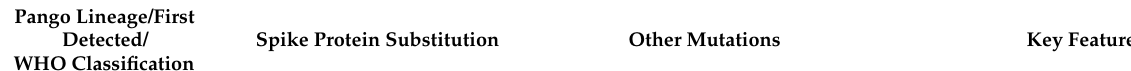
Table 3. Variants of Concern: Mutations and their key features. Table 2. Predominant Spike Mutations associated with SARS-CoV-2 variants. Table 2. Predominant Spike Mutations associated with SARS-CoV-2 variants. Table 2. Predominant Spike Mutations associated with SARS-CoV-2 variants. Table 2. Predominant Spike Mutations associated with SARS-CoV-2 variants. Table 2. Predominant Spike Mutations associated with SARS-CoV-2 variants. Table 2. Predominant Spike Mutations associated with SARS-CoV-2 variants. Table 2. Predominant Spike Mutations associated with SARS-CoV-2 variants.